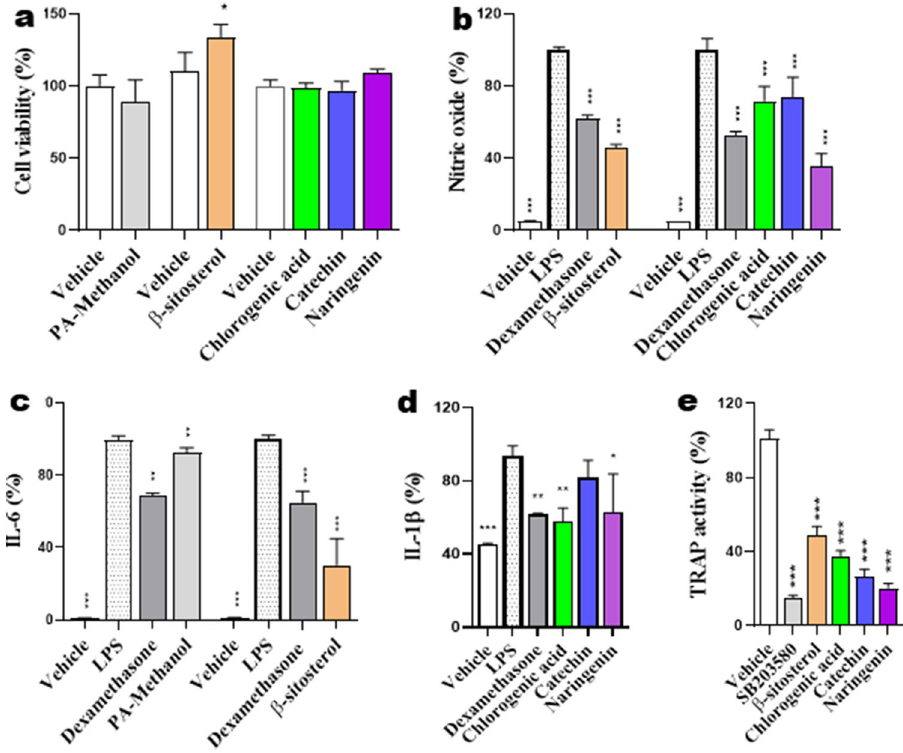
Figure 3. Effects of samples (PA-methanol, β-sitosterol, chlorogenic acid, catechin, and naringenin) on ( a ) cell viability, (b-d) the production of inflammatory factors (nitric oxide, IL-6, or IL-1β), or ( e ) TRAP activity. After 3 h pre-incubation of samples, RAW 264.7 cells were treated with LPS for 6 to 48 h depending on the assay condition. ( a ) Cell viability was measured using a CCK assay. ( b ) Nitric oxide content in the medium was determined using Griess reagent assay; ( c ) IL-6 and ( d ) IL-1β cytokine levels in the medium were measured using ELISA kit. ( e ) TRAP activity was examined by using TRAP buffer containing naphthol AS-MX phosphate. Positive control: 40 or 80 μM dexamethasone. As a control, cells were incubated with the vehicle alone. * p < 0.05, ** p < 0.01 and *** p <